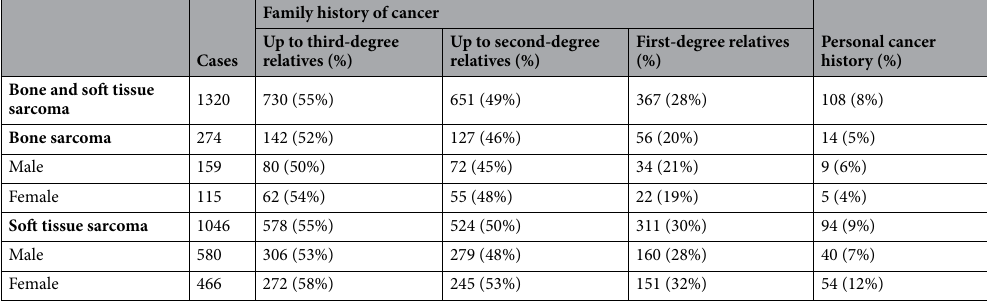
Table 1. Personal and family history of cancer in patients with